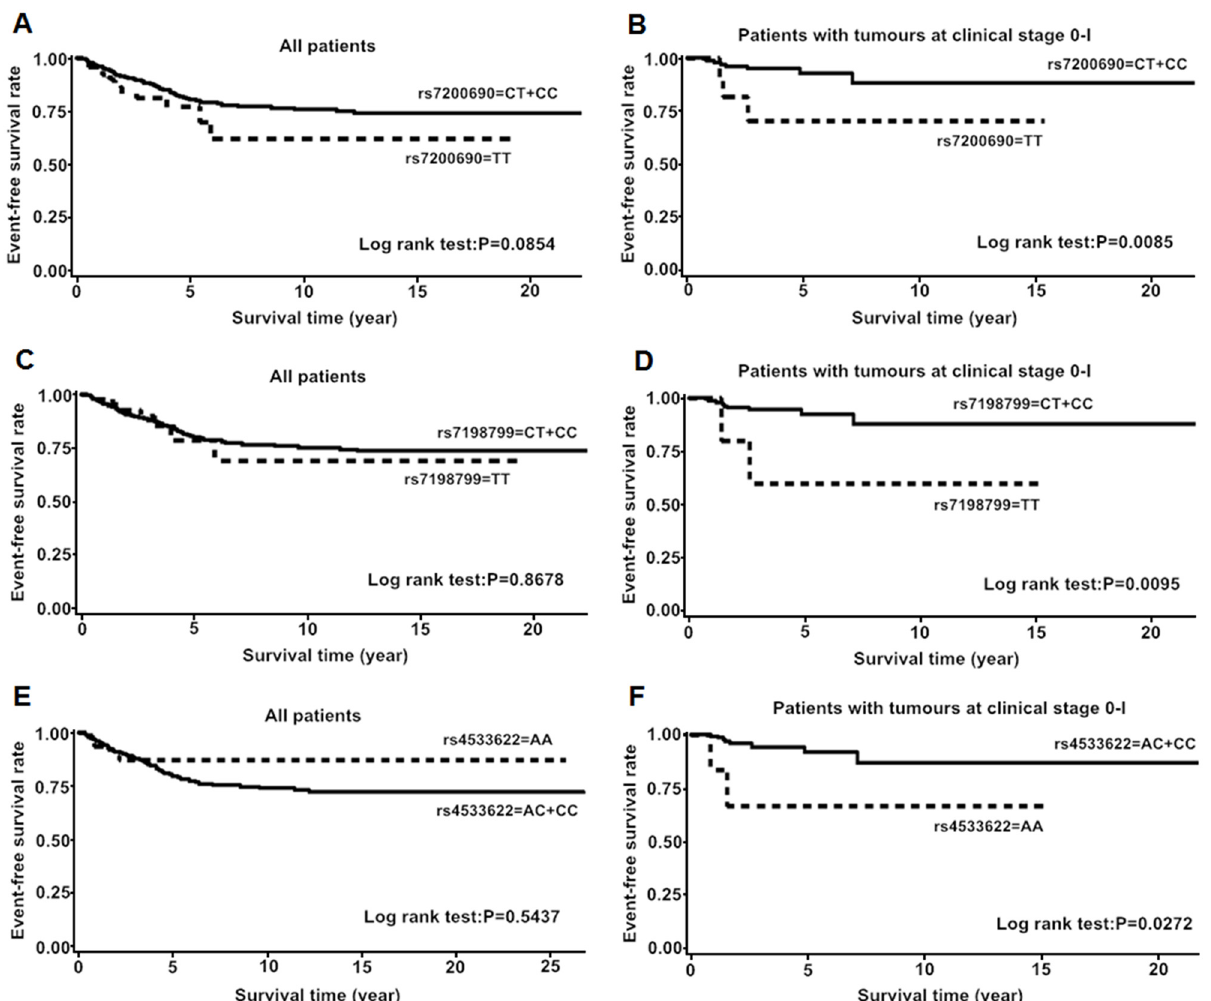
Fig 4. Kaplan-Meier estimates of event-free survival among all patients and patients with stage 0-I tumors respectively. A and B for rs7200690; C and D for rs7198799; E and F for rs4533622. P values were calculated by log rank test.